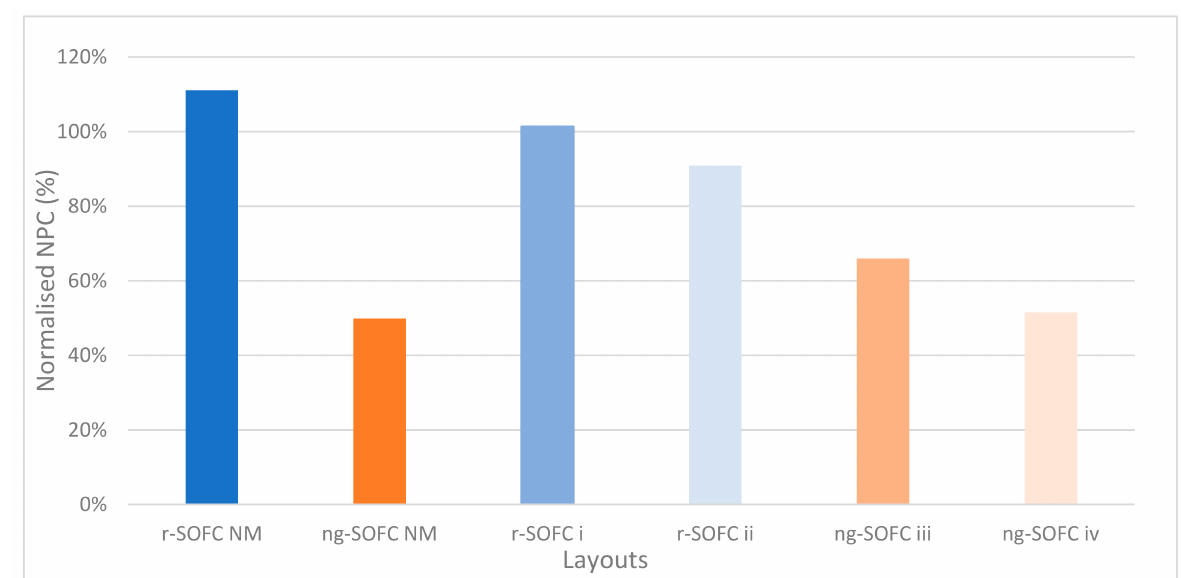
Figure 4. Normalised “operational phase” NPC values in each